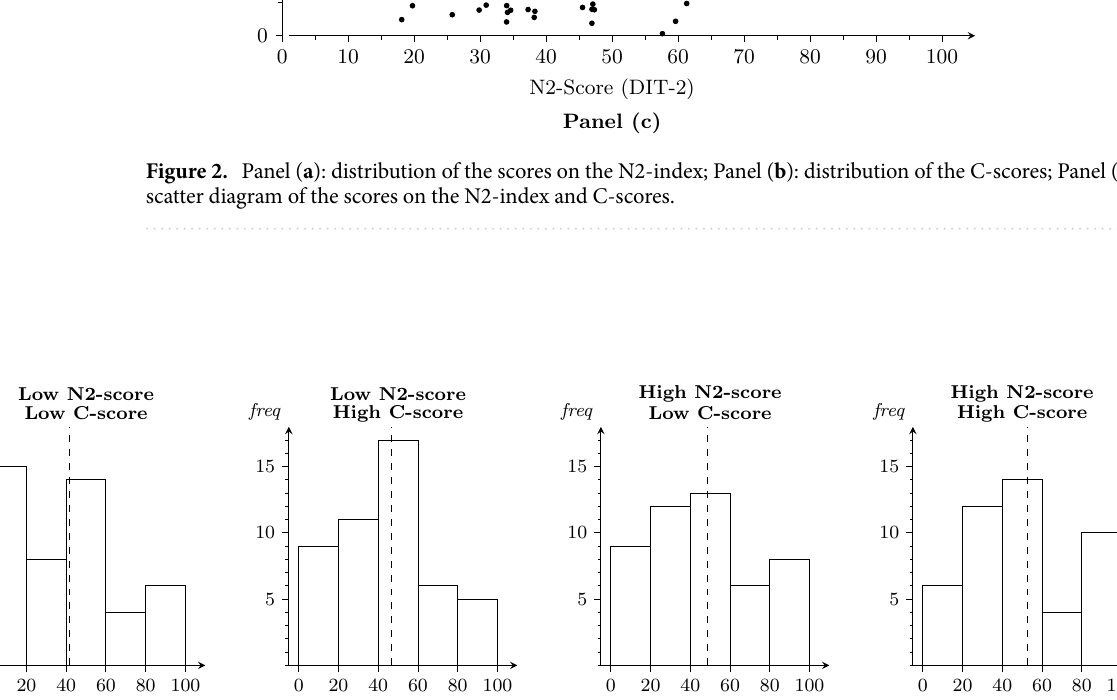
Figure 3. Distribution of individuals’ cooperation rate (percentage of cooperation across all rounds) in function of their N2-index and C-score below or above the median. The dashed line indicates the mean cooperation